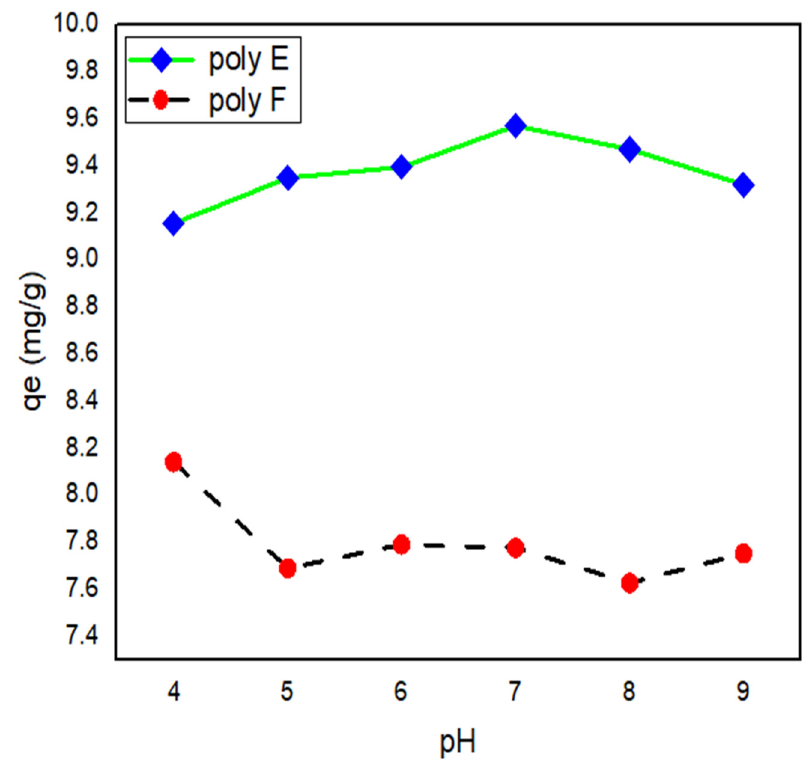
Figure 7. Effect of pH on q e of both polymer F and polymer E for MB adsorption. Experimental conditions were: MB concentration: 100 mg/L; h adsorbents hydrogel dose: 250 mg in 25 mL and RT.